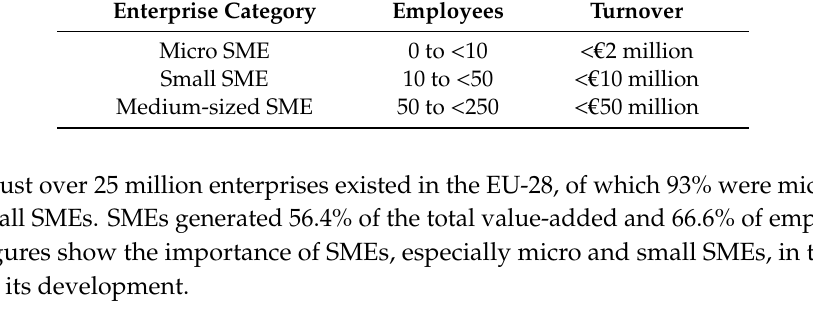
Table 2. Commission recommendation concerning the definition of SMEs. Enterprise Category Employees Turnover Micro